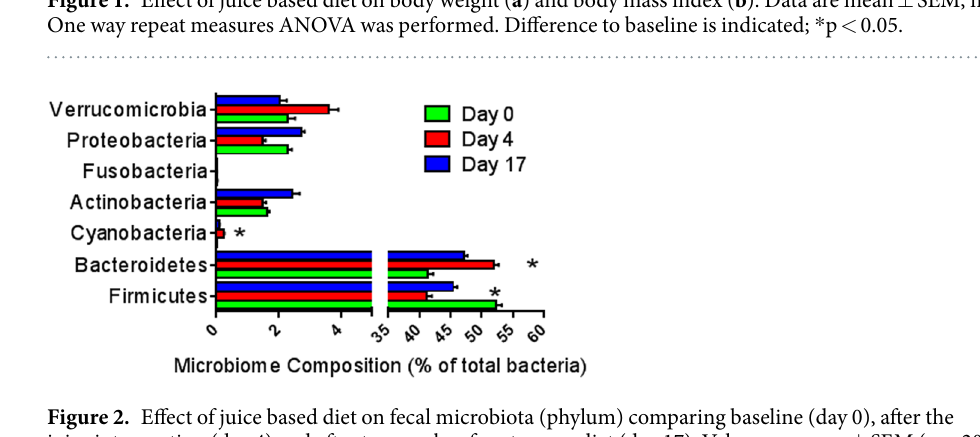
Figure 2. Effect of juice based diet on fecal microbiota (phylum) comparing baseline (day 0), after the juice intervention (day 4) and after two weeks of customary diet (day 17). Values are mean ± SEM (n = 20). Difference to baseline is indicated by * p <